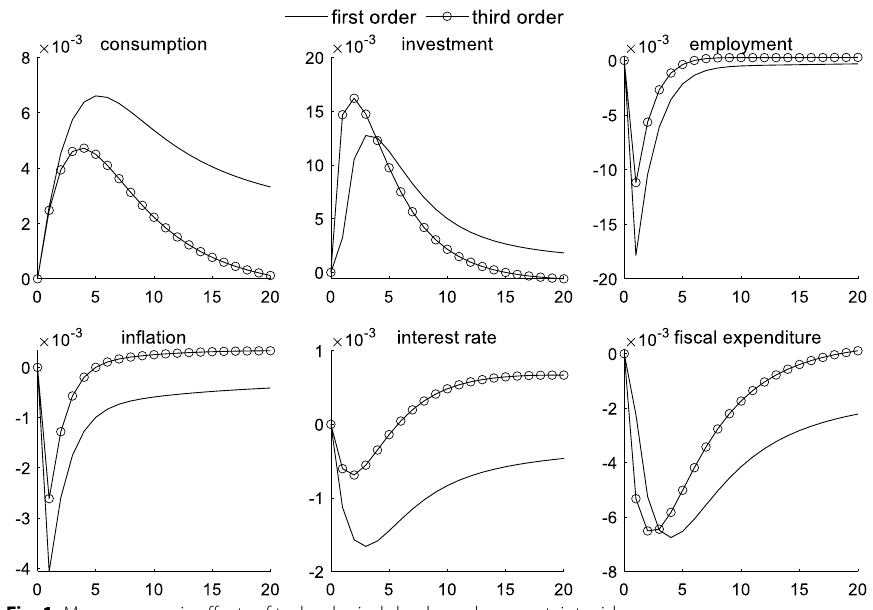
Fig. 1 Macroeconomic effects of technological shocks under uncertainty